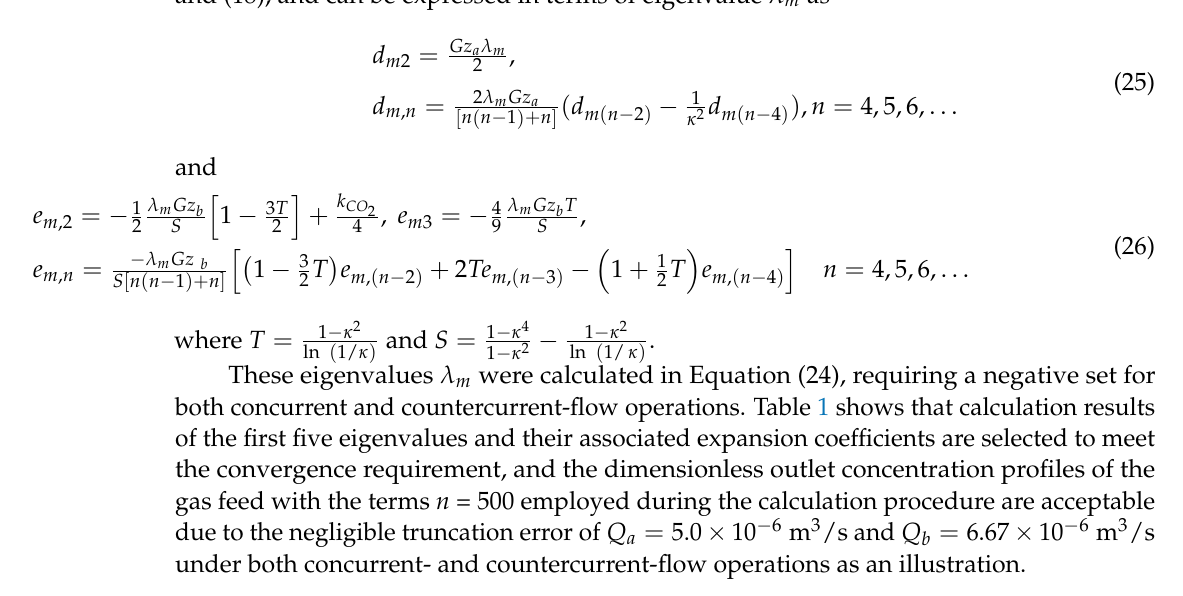
Table 1. The dimensionless outlet concentrations and the associated eigenvalues and expansion coefficients.